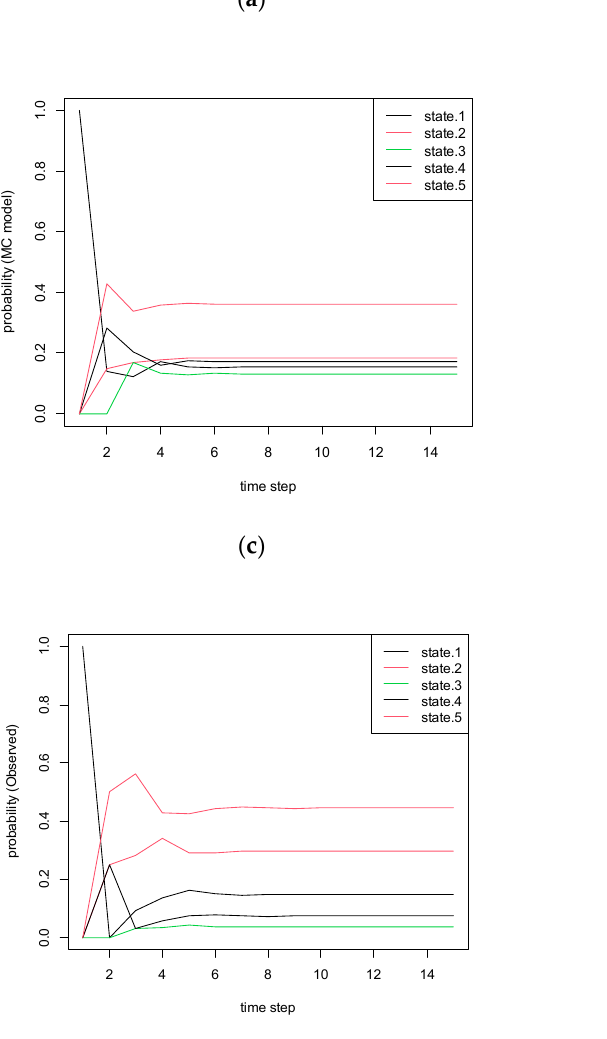
Figure 7. Limiting probabilities of a 5-state Markov chain according to the MC model ( a ), the CMC model ( b ) and the empirical MC of the observed validation data ( c ), as well as the mixing times towards the steady-state probability ( d ). The steady state represents the equilibrium distribution when the mosquito population dynamics is considered as ergodic process.